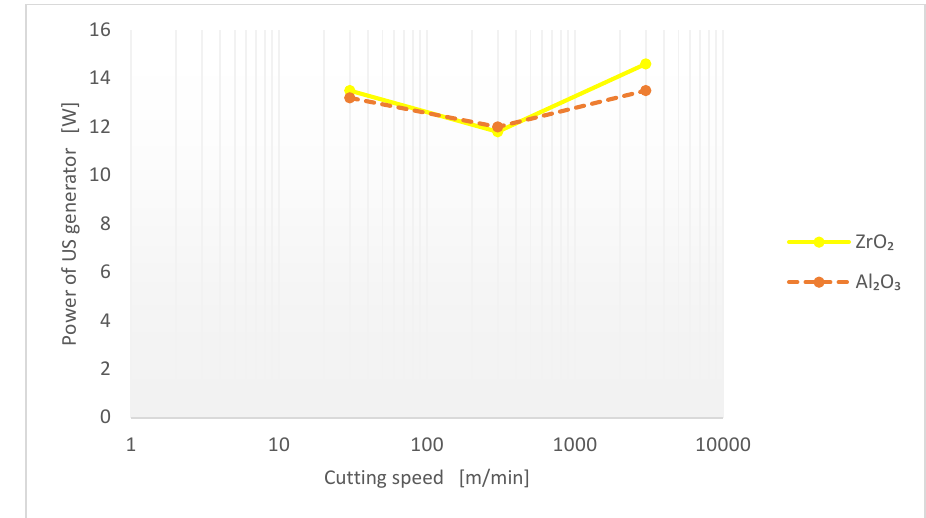
Figure 5. Influence of cutting speed on performance of the ultrasonic generator.